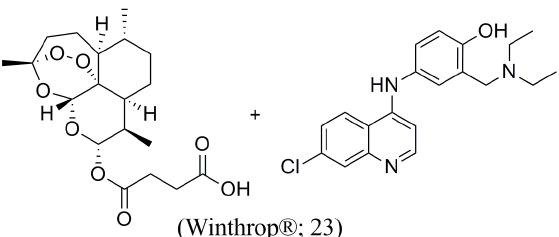
Figure 8 - Structure of drugs used in Winthrop ® combination 23 .